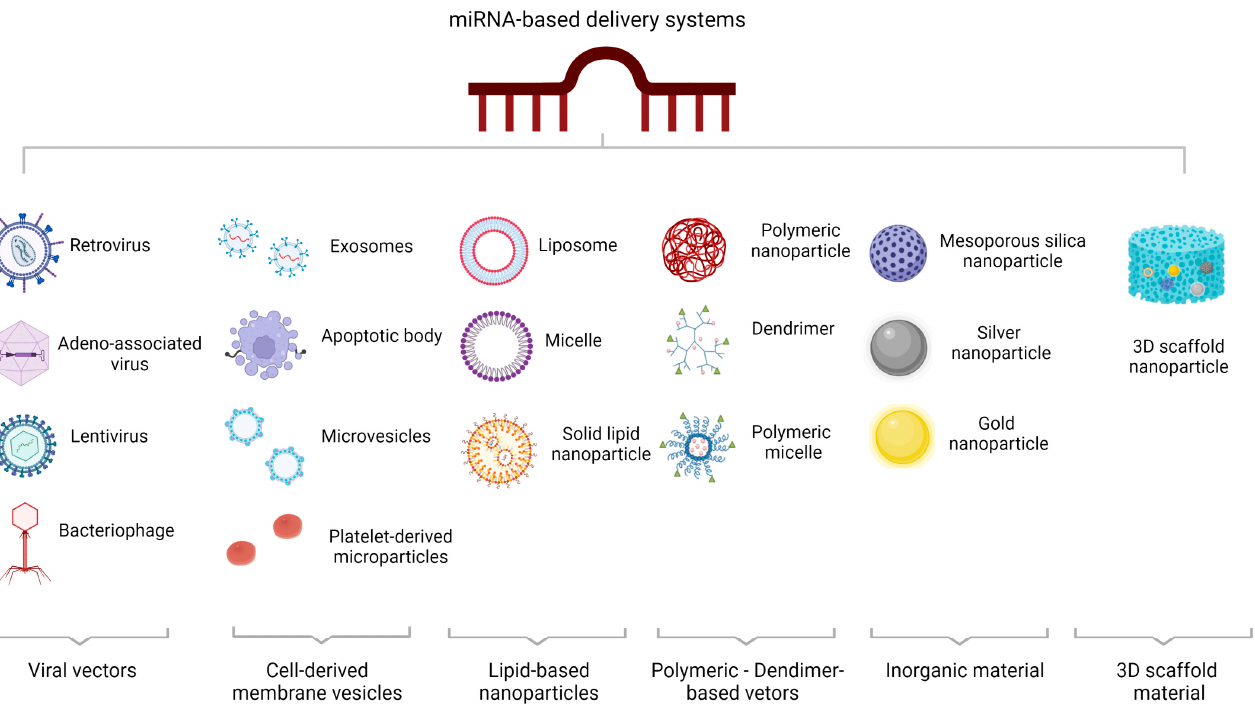
Figure 3. Viral and non-viral miRNA-based delivery systems. Nonviral miRNA-based delivery systems are divided into several categories: cell-derived membrane vesicles, lipid-based nanoparticles, polymeric vectors/dendrimer-based vectors, inorganic material-based delivery systems, and 3D scaffold-based delivery systems. This figure was generated using BioRender, Available online: https://biorender.com (accessed on 29 September 2022) .